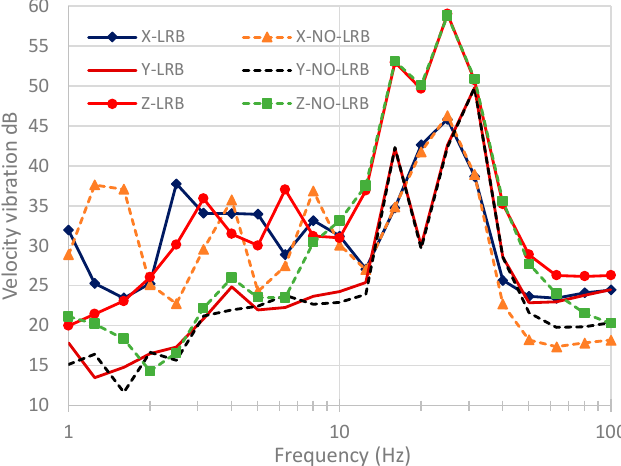
Figure 10. Velocity vibration dB at 10 m from the centerline of the crane railway on the first steel level for the factory with or without